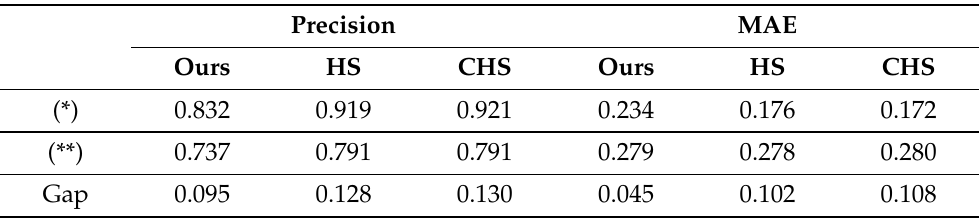
Table 7. Performance drop for Precision and MAE measures with respect to image numbers 0 to 500 (*) and 500 to 1000 (**) of the ECSSD dataset (for MAE, the smaller value is the best).